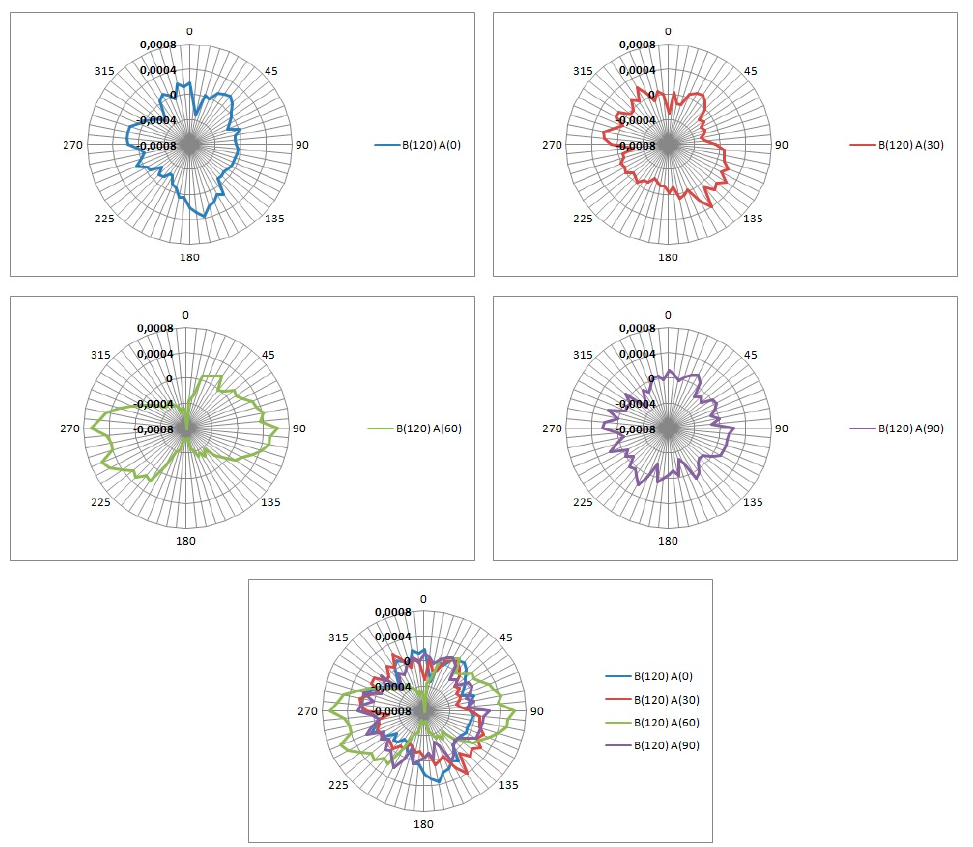
Figure 4. Results of identification of errors for a B angle equal to 120° and A changing in the range 0–90°. All angles given in degrees and errors in mm.